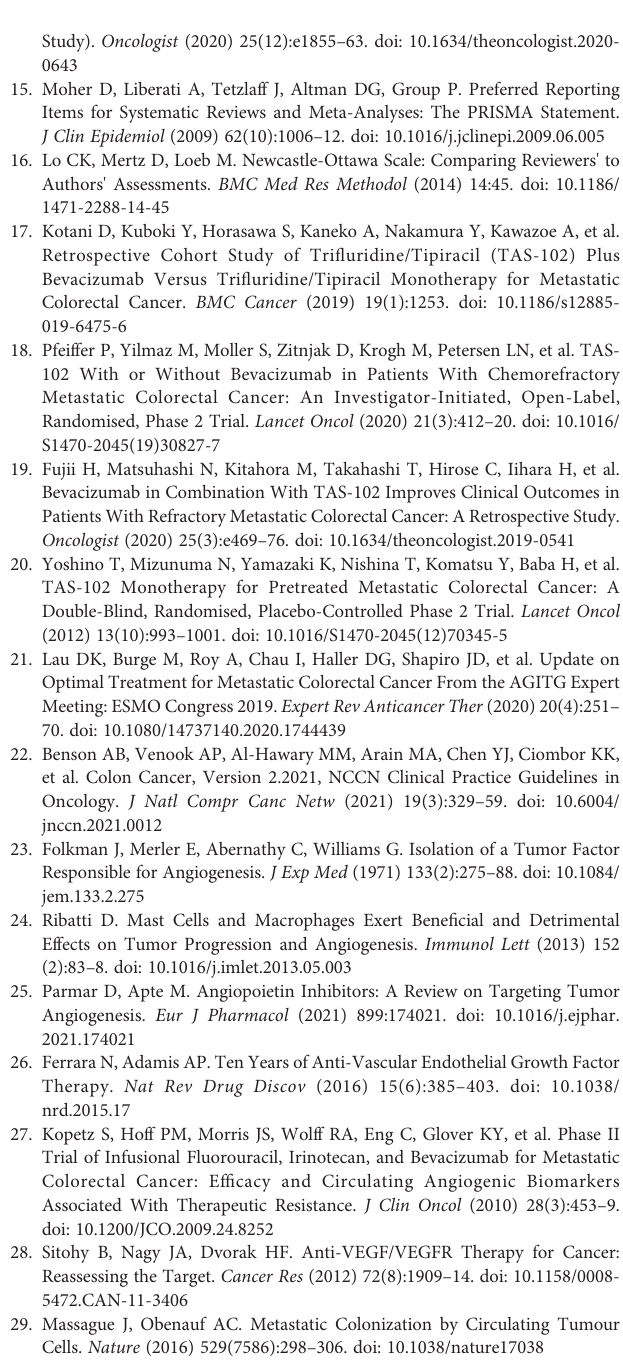
Supplementary Figure S1 | Funnel plot for publication bias. (A) Funnel plot in the studies involving 6-month overall survival; (B) Funnel plot in the studies involving severe side effects (grade ≥